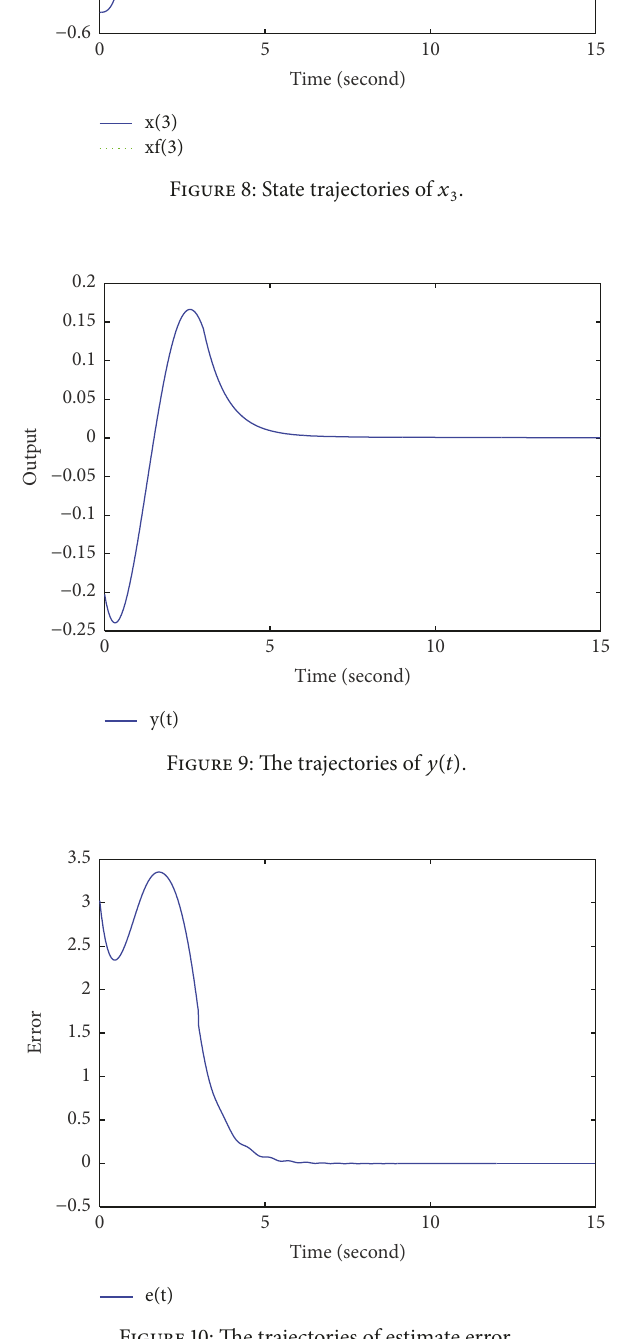
Figure 10: The trajectories of estimate error.